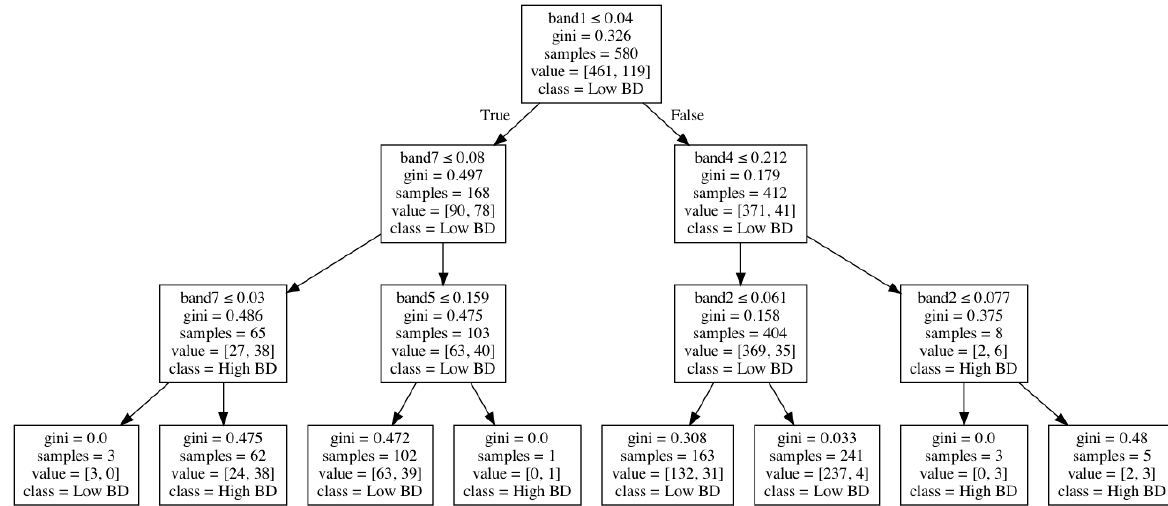
Figure 4. An example of the decision tree for bulk density classification.